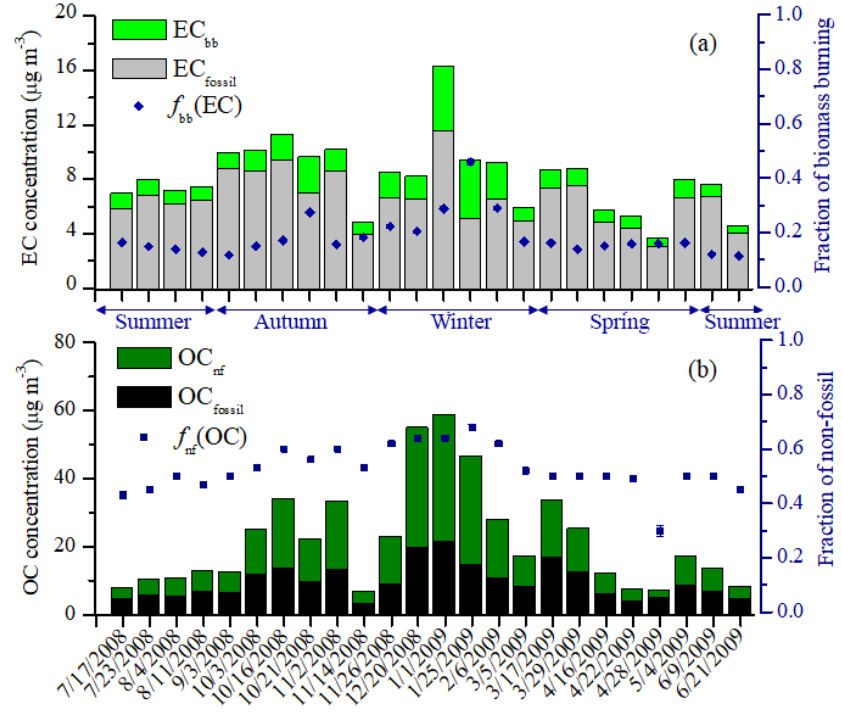
Figure 1. (a) Temporal variation of EC mass concentrations from biomass burning (EC bb ) and fossil fuel combustion (EC fossil ), and fraction of biomass burning contribution to EC ( f bb (EC)). (b) Temporal variation of OC mass concentrations from non-fossil sources (OC nf ) and fossil sources (OC fossil ), and fraction of non-fossil OC to total OC ( f nf